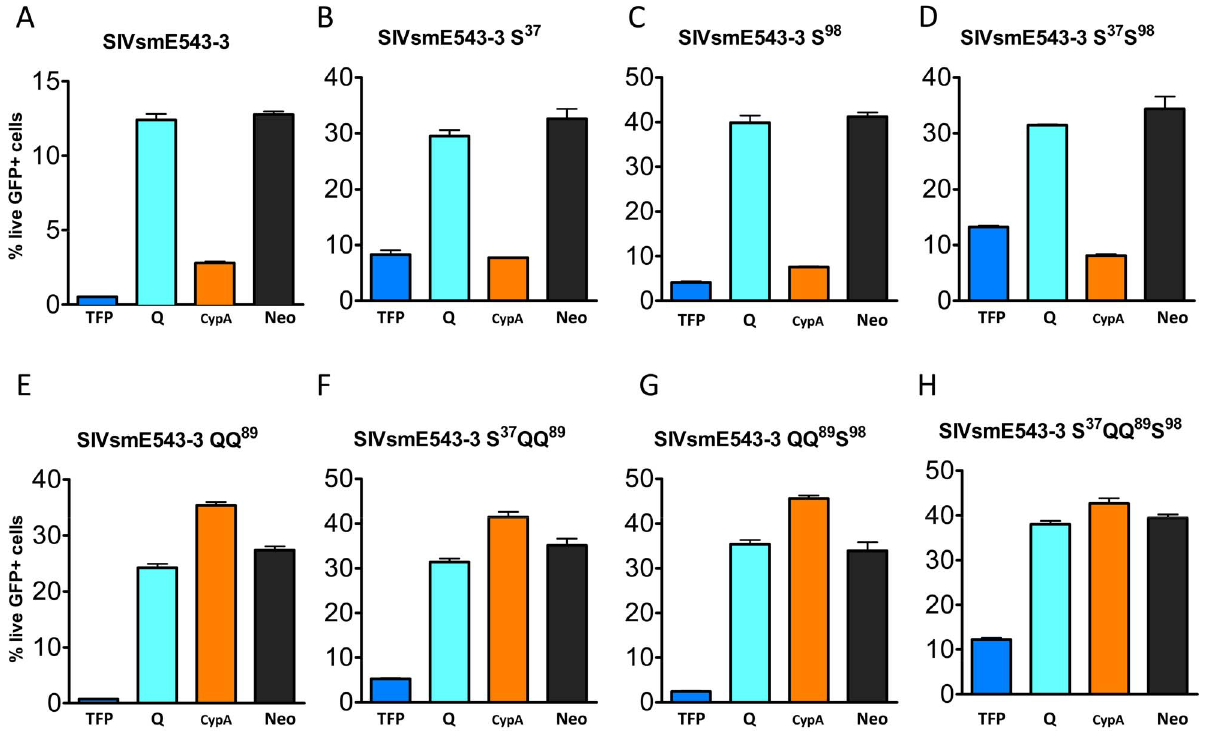
Figure 4. Introduction of amino acid substitutions into SIVsmE543-3 capsid conferred virus resistance to TRIM5 restriction. Single or combinations of amino acid substitutions ‘‘P37S’’, ‘‘LPA89QQ’’ and ‘‘R98S’’ were introduced into SIVsmE543-3 capsid. Single-cycle infectivity of these mutants was measured on a panel of cell lines stably expressing a TRIM5 TFP allele (Mamu-2, dark blue bars), TRIM5 Q alleles (Mamu-4, light blue bars) and TRIM5 CypA (orange bars). Infectivity was measured as percent GFP positive cells. Black bars are negative vector controls. Infectivity on this panel are shown for SIVsmE543-3 ( A ), SIVsmE543-3 S 37 ( B ), SIVsmE543-3 S 98 ( C ), SIVsmE5433-3 S 37 S 98 ( D ), SIVsmE543-3 QQ 89 ( E ), SIVsmE543-3 S 37 QQ 89 ( F ), SIVsmE543-3 QQ 89 S 98 ( G ) and SIVsmE543-3 S 37 QQ 89 S 98 ( H ).